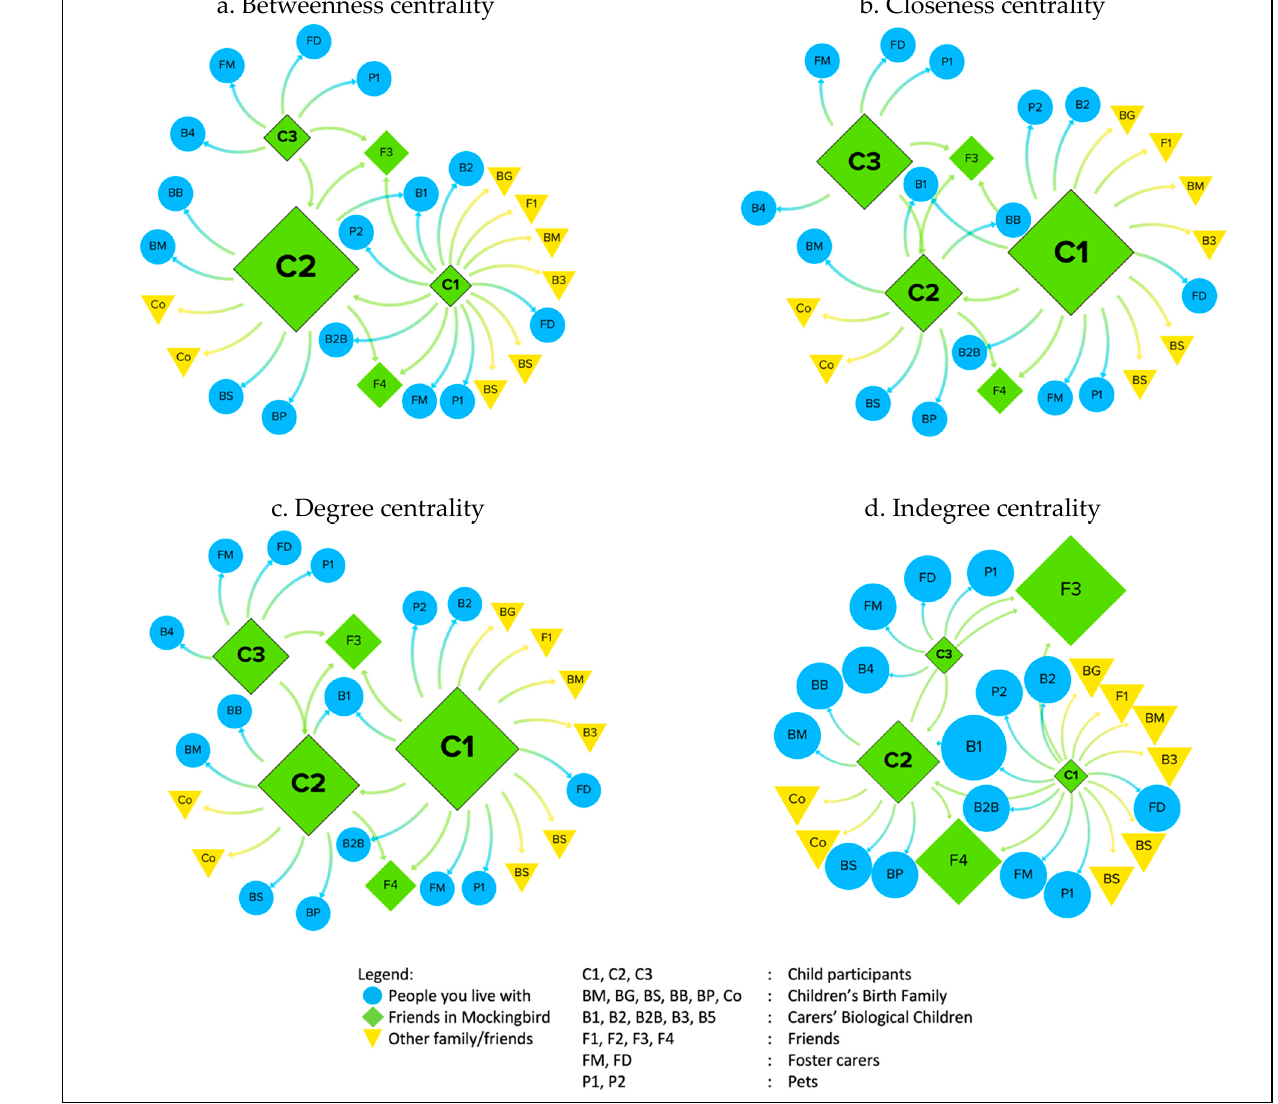
Figure 5. Visualization of selected metrics.